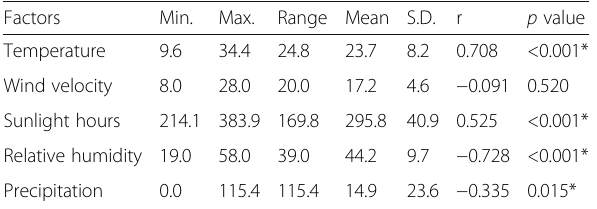
Table 4 Correlation coefficients (r) of scorpion stings and the averages of monthly climate factors Factors